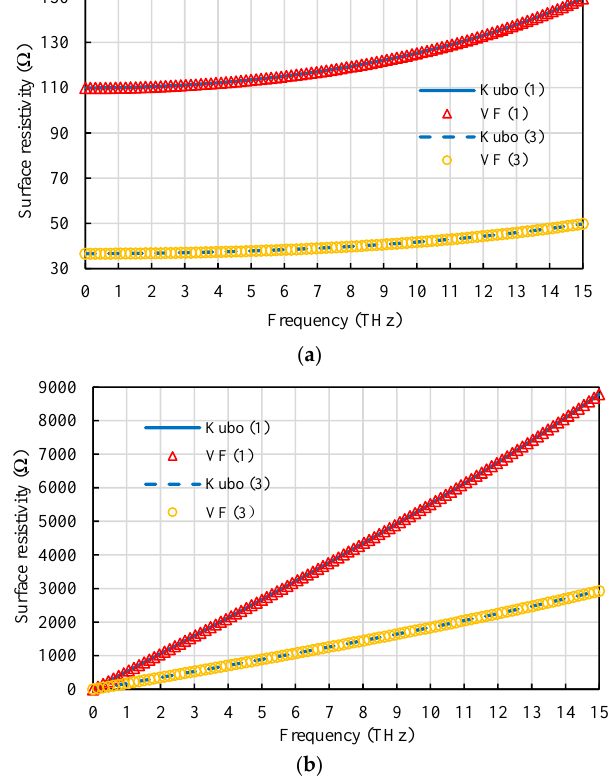
Figure 4. Monolayer and trilayer graphene surface resistivity: ( a ) real parts; ( b ) imaginary parts. The incident excitation is the modulated Gaussian pulse defined by